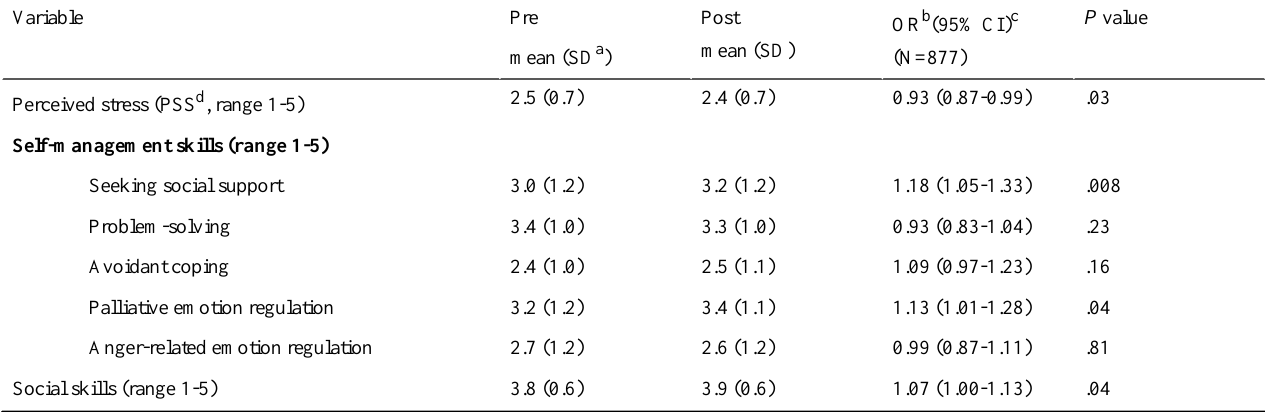
c Linear generalized estimation equation (GEE) models, with time variable (baseline vs follow-up assessment) as the predictor, adjusted for attrition bias. d PSS: Perceived Stress